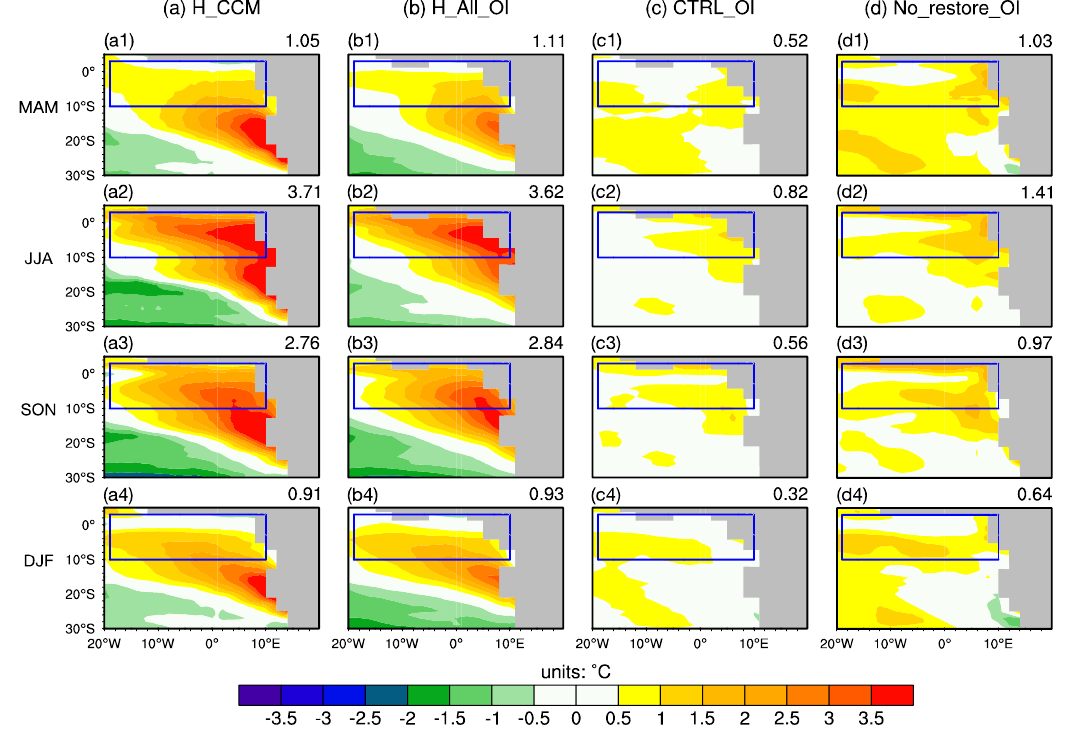
Figure 5. The seasonal mean SST bias (unit: °C) in MAM (top), JJA (second row), September–November (SON; third row) and December–February (DJF; bottom) during 1979–2005. The first column is for the H_CCM experiment ( a ); the second for the H_All_OI experiment ( b ); the third for the CTRL_OI experiment ( c ); and the fourth for the No_restore_OI experiment ( d ). The blue box denotes the ACT region. The root mean square error (RMSE) of SST in the box is given on the top right of each panel.